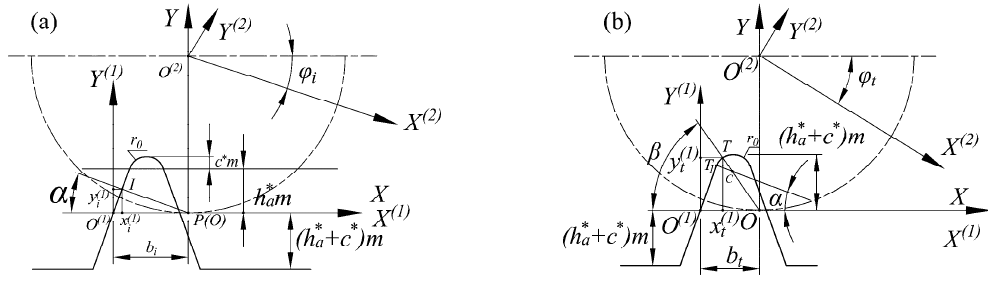
Figure 1. The principle of the generating method: ( a ) involute; ( b ) transition curve. The subscripts 𝑖 and 𝑡 in Figure 1 denote the involute curve and transition curve. Equations of the involute curve are expressed as